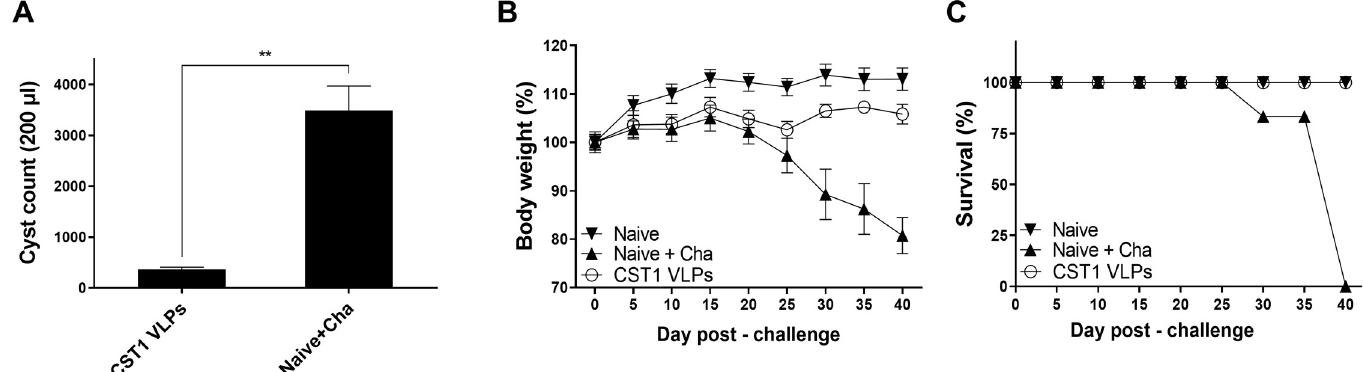
Fig 8. Cyst count, bodyweight and survival. BALB/c mice were orally challenge-infected with a lethal dose of T . gondii 4 weeks after the boost immunization. Brain tissues were harvested at 40 dpi and (A) cysts were enumerated after isolation from brain homogenates. (B) Changes in bodyweight and (C) survival rates were assessed daily after challenge infection. Data are shown as mean ± SD, and asterisks denote statistical significance between the groups ( ** P < 0.01). Tissue samples were collected on an individual basis and representative data acquired from 2 independent vaccination and challenge infection studies were used.